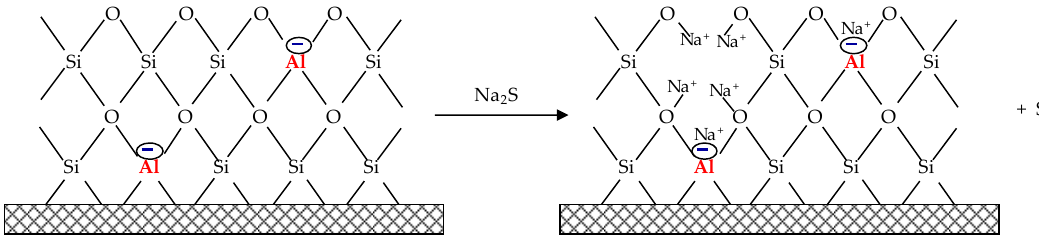
Figure 1. Schematic representation of zeolite configuration after silicon dissolution in a strong alkaline medium. Since it was found that sulfur modification caused an increase in basicity and thus an increase in the net negative zeolite charge, the chemical behavior of NZ and SZ was estimated from the dependence of pH e on different pH o values at the two ionic strengths of the electrolyte (Figure 2).